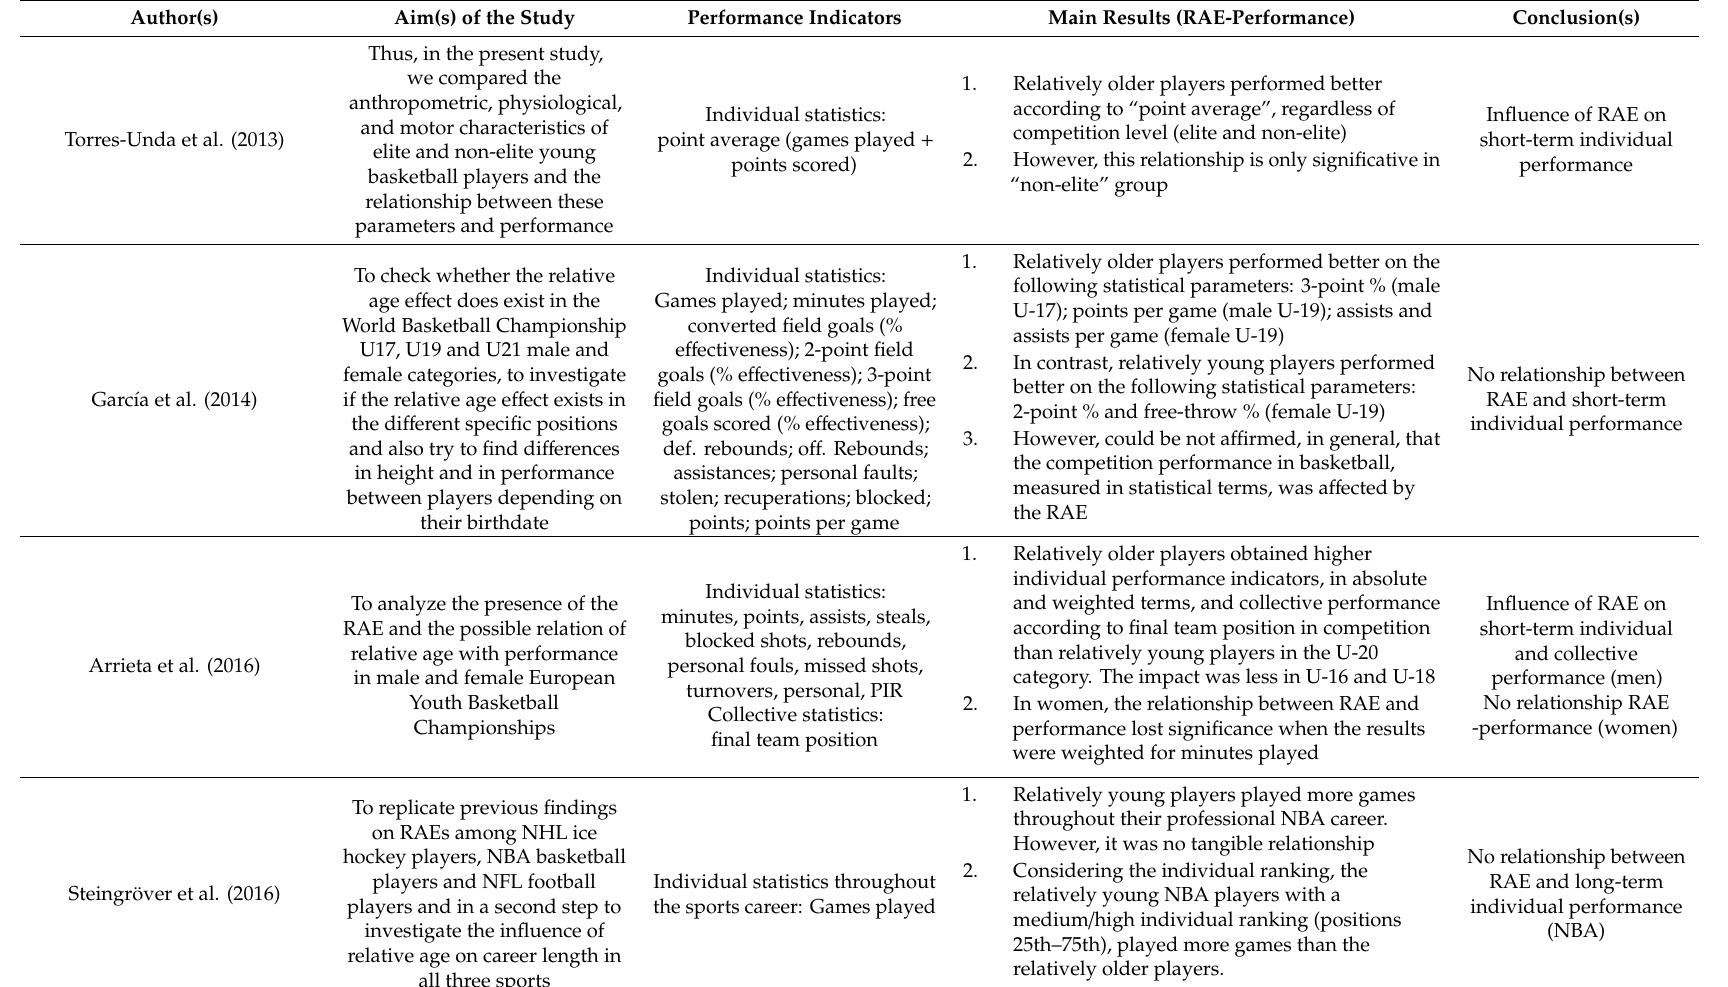
Table 3. Relationship between the relative age e ff ect (RAE) and competition performance providing aim(s) of the study, performance indicators, main results and